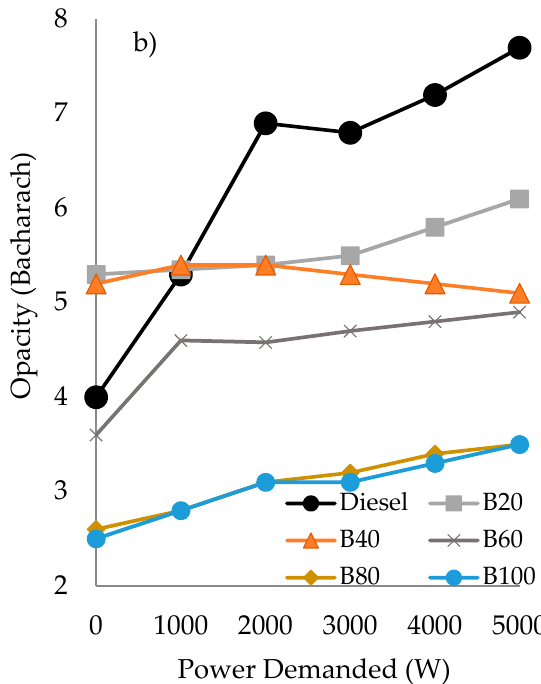
Figure 3. Power generated (in Watts), based on the power demanded (in Watts) ( a ) and opacity (in Bacharach) as a function of the power demanded ( b ) by the triple blends of diesel / gasoline / castor oil. As can be seen, at low power demand (1000 W), the consumption of the blends is always higher than that obtained with fossil diesel, independently of the oil employed in the blend. However, at the highest power demanded (5000 W), the opposite behavior is observed. In fact, at 5000 W of power demanded, only the double blends of gasoline / oil exhibited higher consumption than diesel (20% higher with sunflower and 10% with castor oil). Anyway, it can be observed that the blends obtained using castor oil exhibited a lower consumption than their counterparts employing sunflower oil.